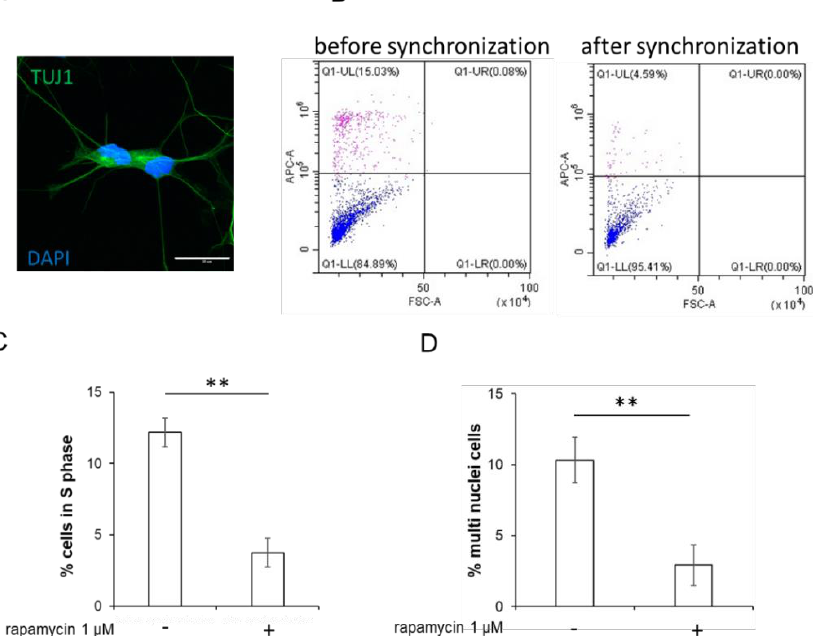
Figure 1. Cell cycle synchronization and experimental design of modified protocol. ( A ) Representa- tive image of the neuron, obtained with original protocol and containing two nuclei. Immunofluores- cent staining of induced neuron with antibodies for the neuronal marker protein TUJ1 (secondary antibodies conjugated with the Alexa 488 fluorophore). DAPI was used for identification of cell nuclei. Confocal microscopy, × 60. The scale bar corresponds to 20 µ m. ( B ) Detection of divided cells by flow cytometry analysis of DNA content in primary human dermal fibroblasts stained with Edu kit and not subjected to (−) or subjected (+) to the cell cycle synchronization with 1 μM rapamycin for 48 h. ( C ) Percentages of cells in the S phases of the cell cycle without or with synchronization for 48 h with rapamycin. Data are presented as the mean ± SEM. **: p < 0.01. Student‘s t -test. ( D ) Per- centages of multinucleated neurons at the end reprogramming procedure reprogrammed according to the original and modified protocol. n = 272 neurons for original protocol, n = 330 neurons for modified protocol. **: p < 0.01. Student‘s t -test.